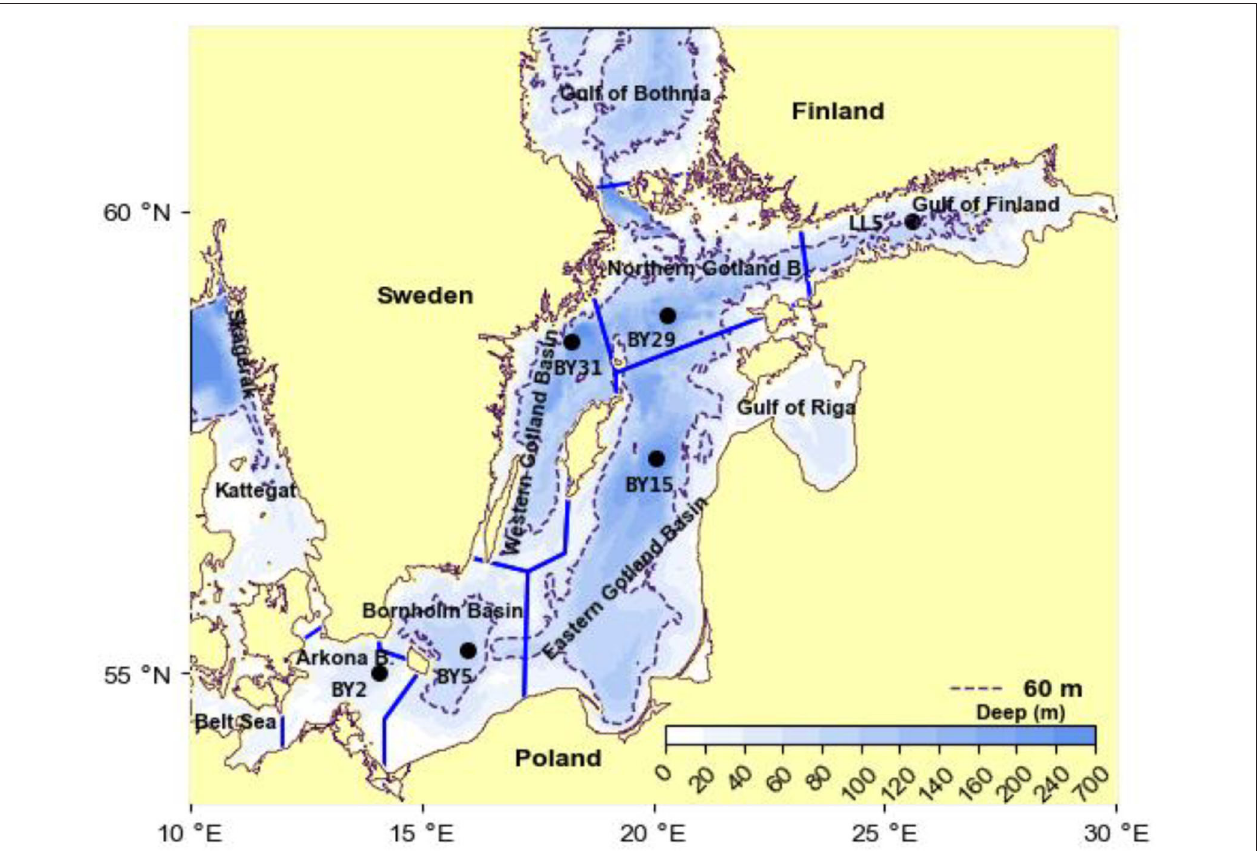
FIGURE 2 | Topographic map of the Baltic proper showing the partition into deep basins. The Gulf of Riga is included in the Eastern Gotland Basin. Hydrographical data come from the stations marked in the map, see the section